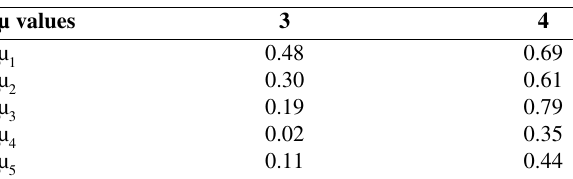
–μ calculated from the EI mass spectra of 1 5